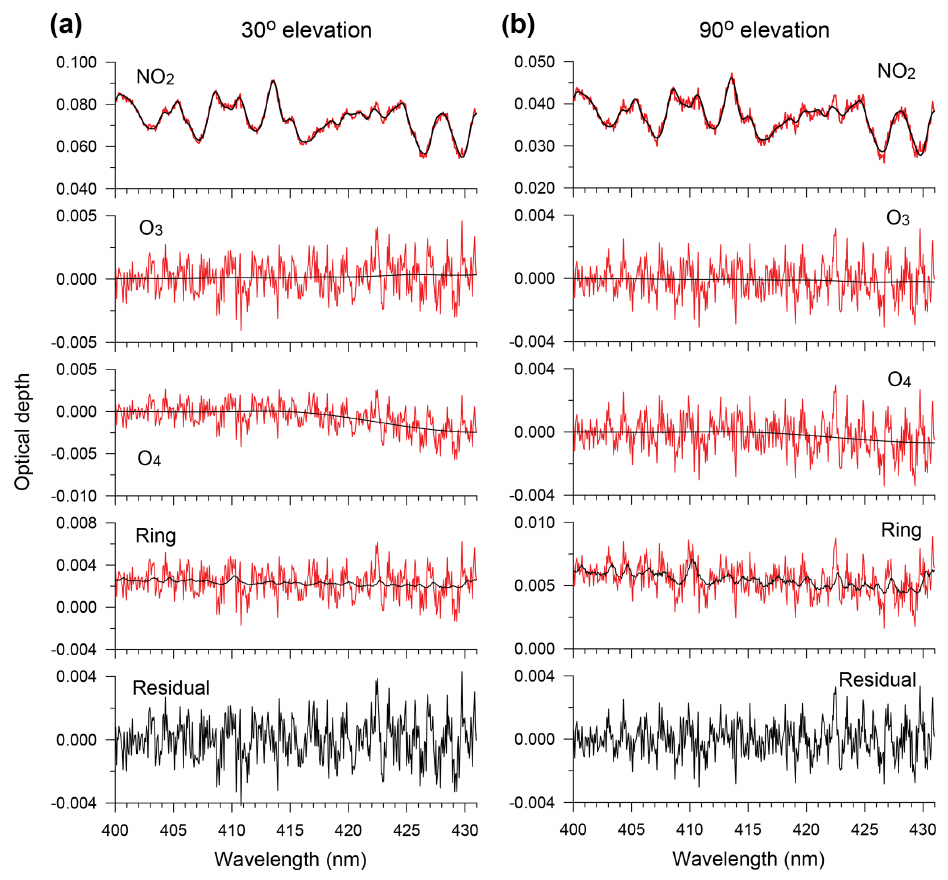
Figure 2. Examples of the NO 2 retrieval from two successive spectra measured (a) at a 30 ◦ elevation angle (with NO 2 differential slant column density (DSCD) of 1 . 2 × 10 17 molec.cm − 2 ) and (b) at a 90 ◦ elevation angle (with NO 2 DSCD of 6 . 2 × 10 16 molec.cm − 2 ) on 18 January 2014, at around